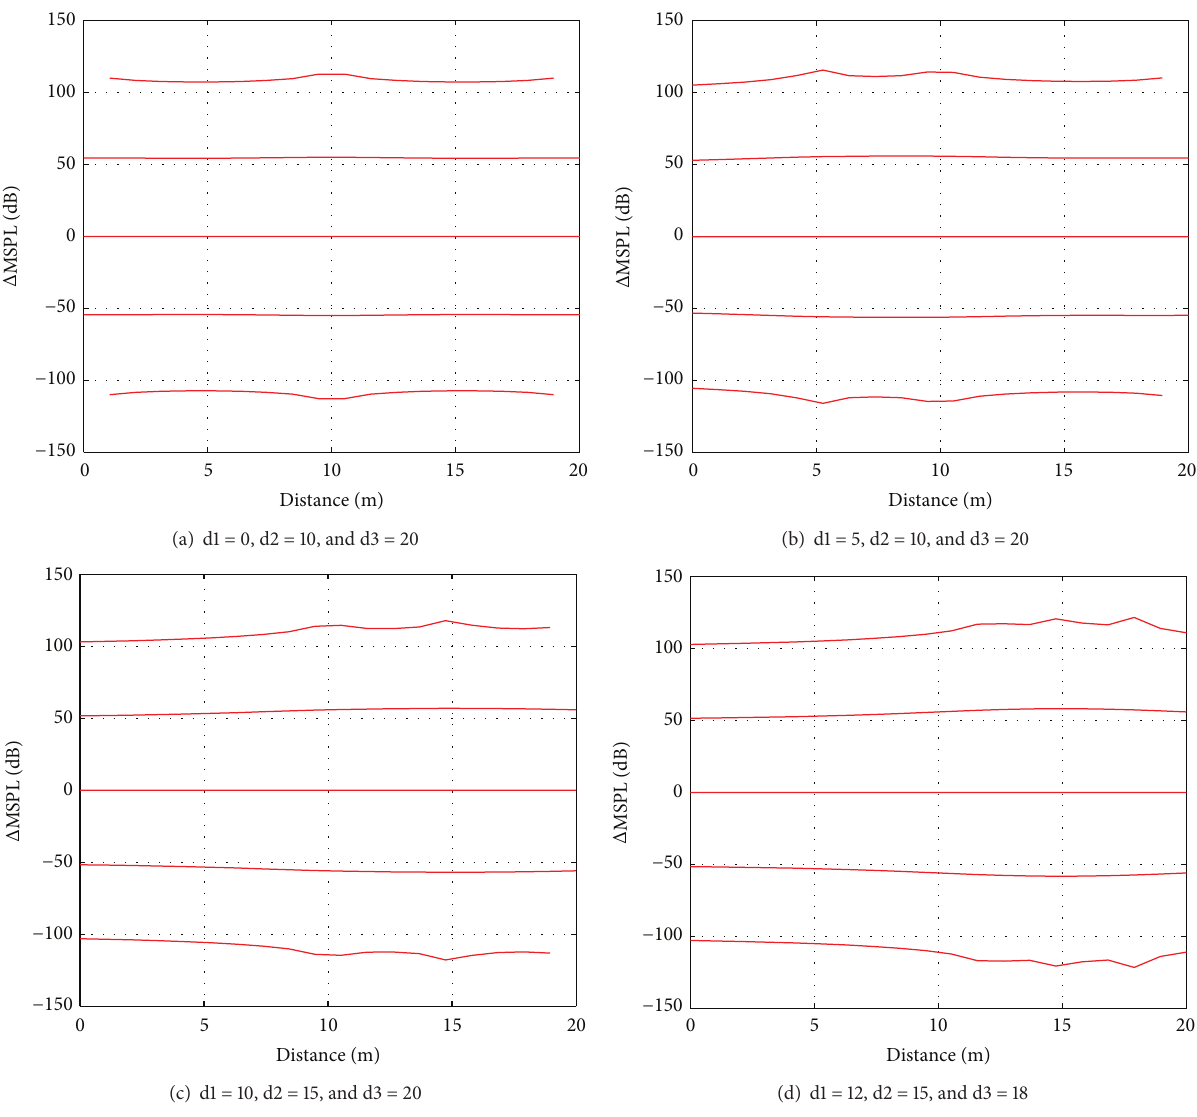
Figure 4: Δ MSPL with 3 anchor